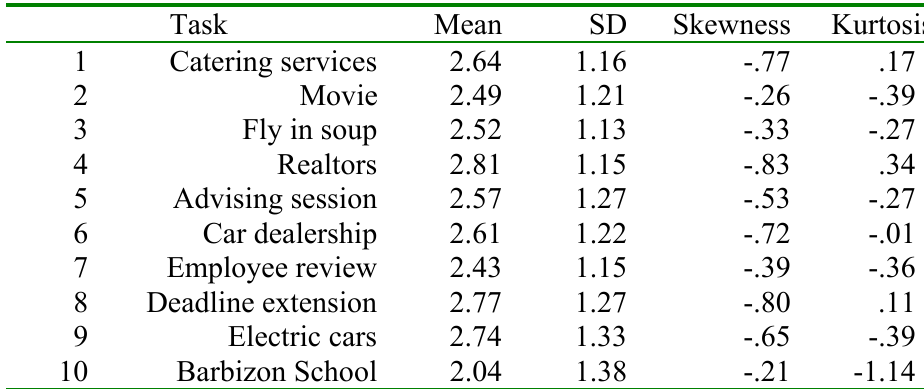
Descriptive Statistics for the Ten Tasks